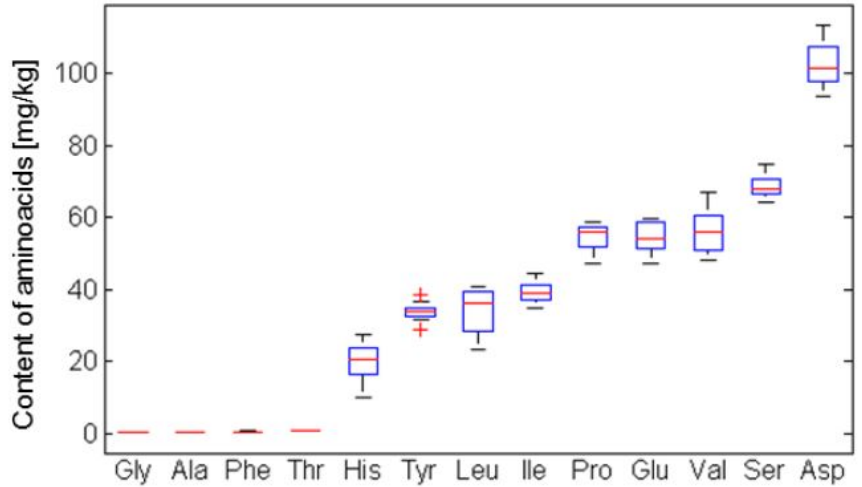
Figure 7. Box plot graphs in the distribution of determined amino acids.